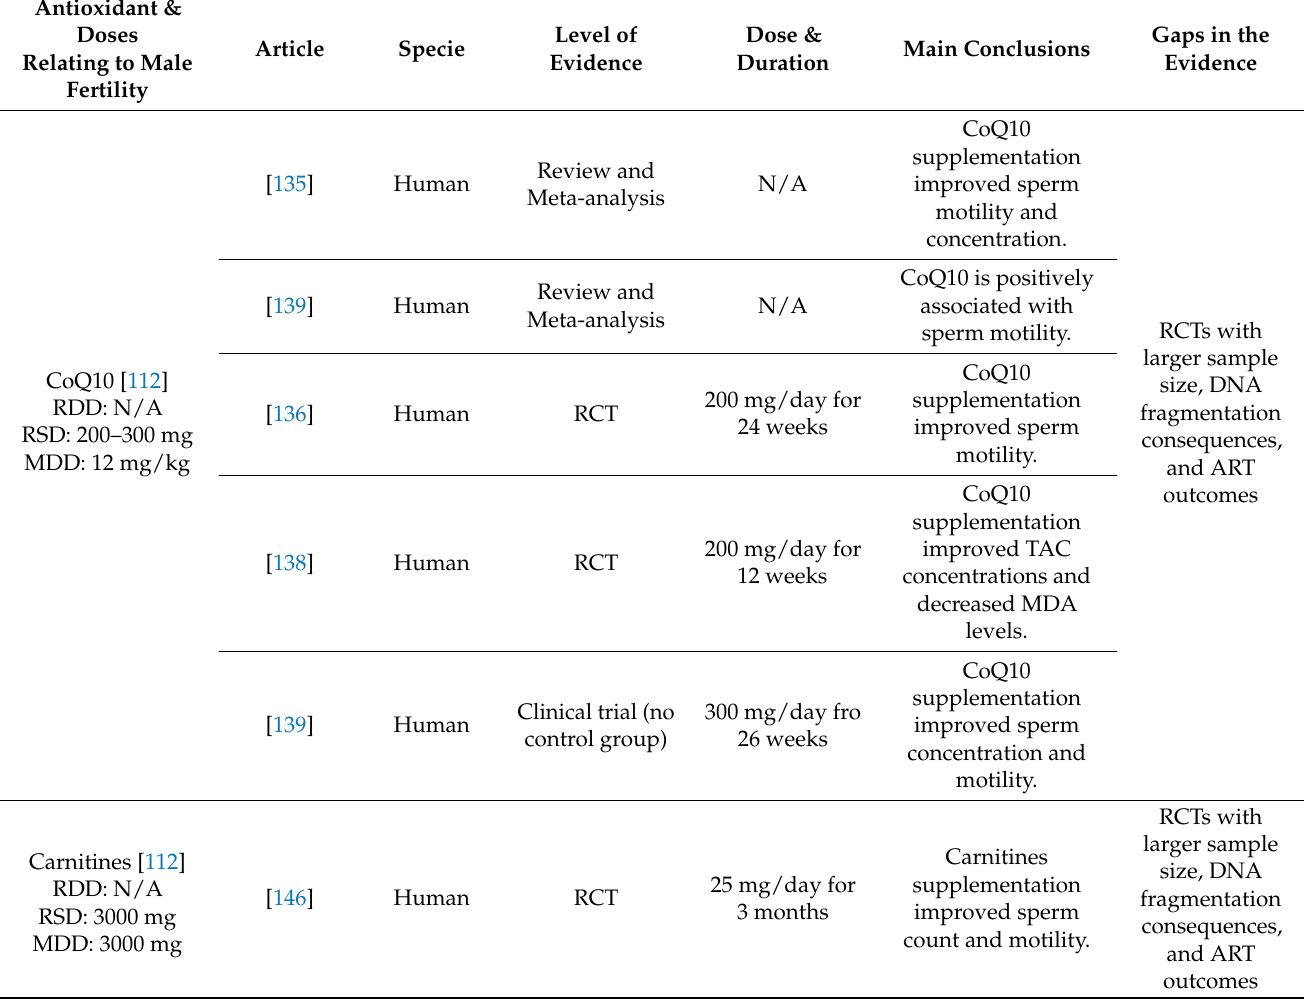
Table 2. Main positive associations or effects of single antioxidants related to sperm quality/male fertility by biologi- cal